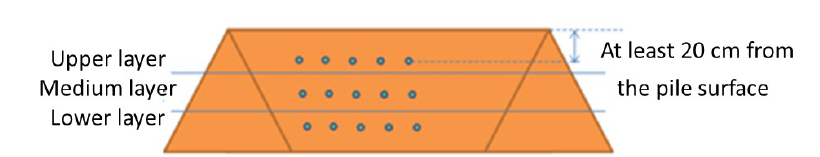
Fig. 2. Sampling points in the manure compost